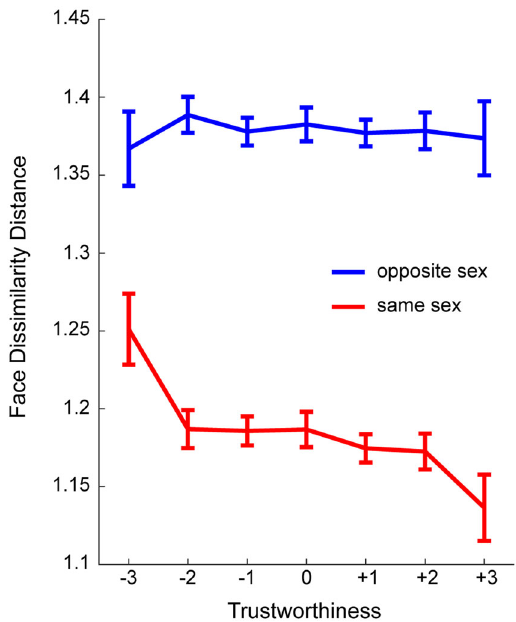
Fig. 2 Relationship between trustworthiness and face dissimilarity distance. The red line represents the face dissimilarity distance between the evaluator and face model when both were of the same sex, and the blue line represents the distance between the two when they were of opposite